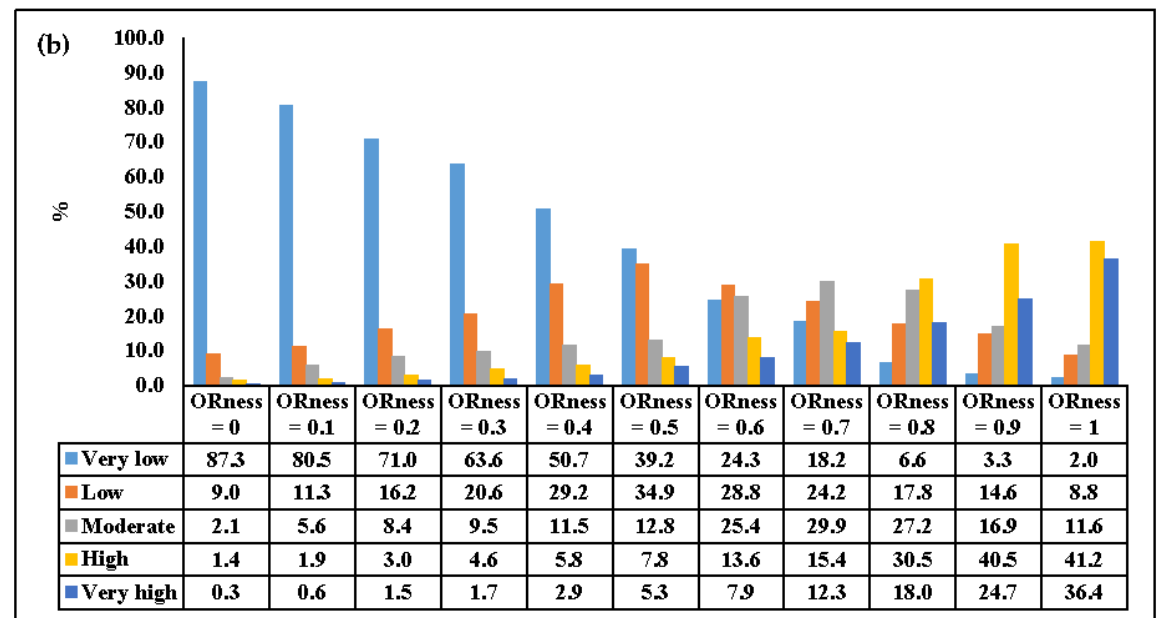
Figure 7. ( a ) Vulnerability sensitivity analysis with initial weights; ( b ) vulnerability sensitivity analysis by changing the weight criterion of the distance from river.